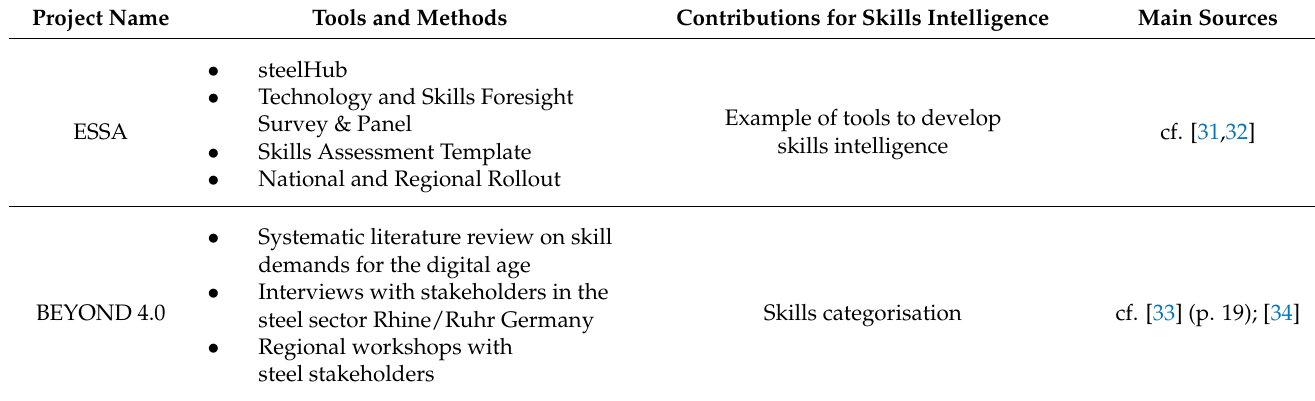
Table 2. Overview of